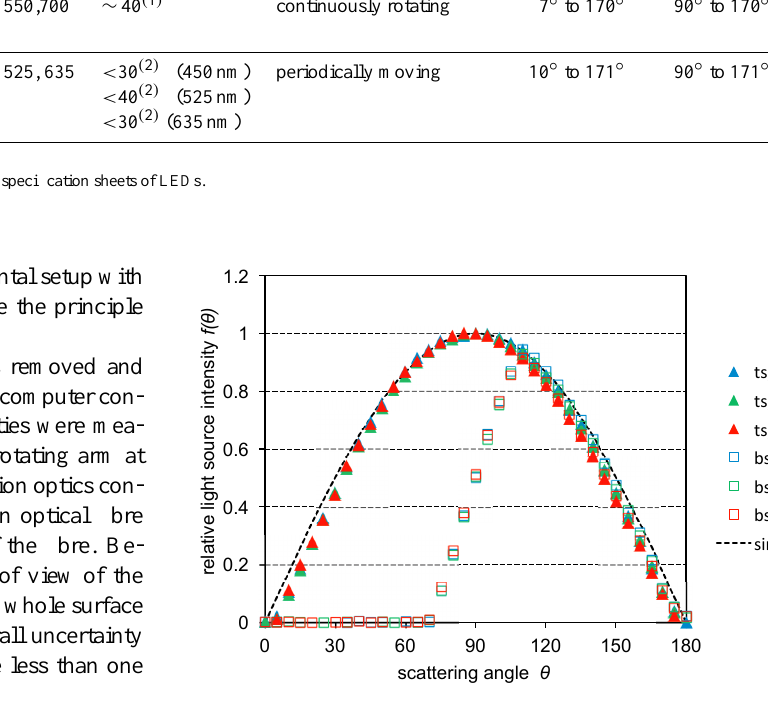
Fig. 2. Measured angular intensity functions for nephelometer model Aurora 3000. The wavelengths are indicated by B (450nm), G (525nm), and R (635nm), respectively. Total scattering and backscattering are indicated by ts and bs respectively. For com- parison purposes, the total angular intensity functions have been